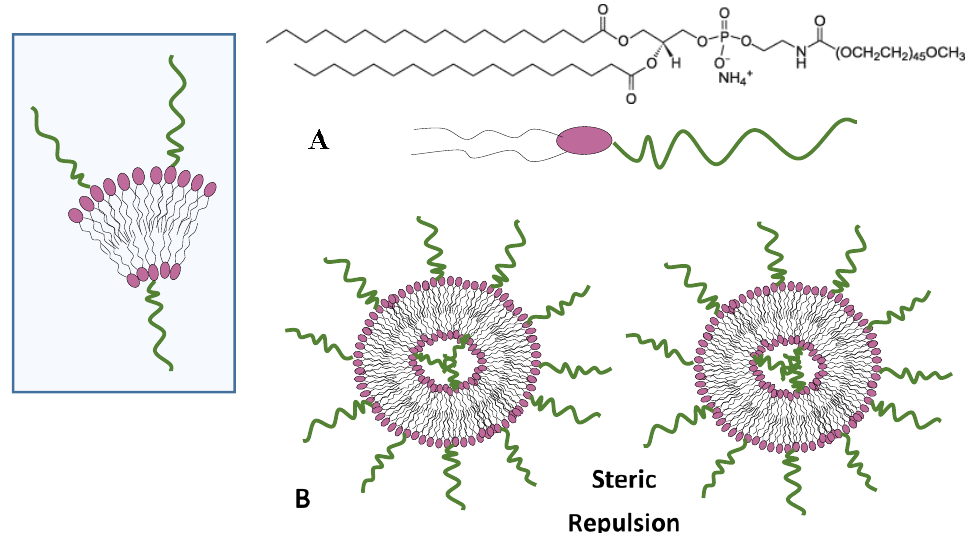
Figure 4. Schematic representation of the PEGylated phospholipid (DSPE-PEG2000) 1,2-distearoyl-sn-glycero-3-phosphoethanolamine-N-[methoxy(polyethyleneglycol)-2000] ammonium salt ( A ). View of sterically stabilised lipid bilayers ( B ). PEG, polyethylene glycol.